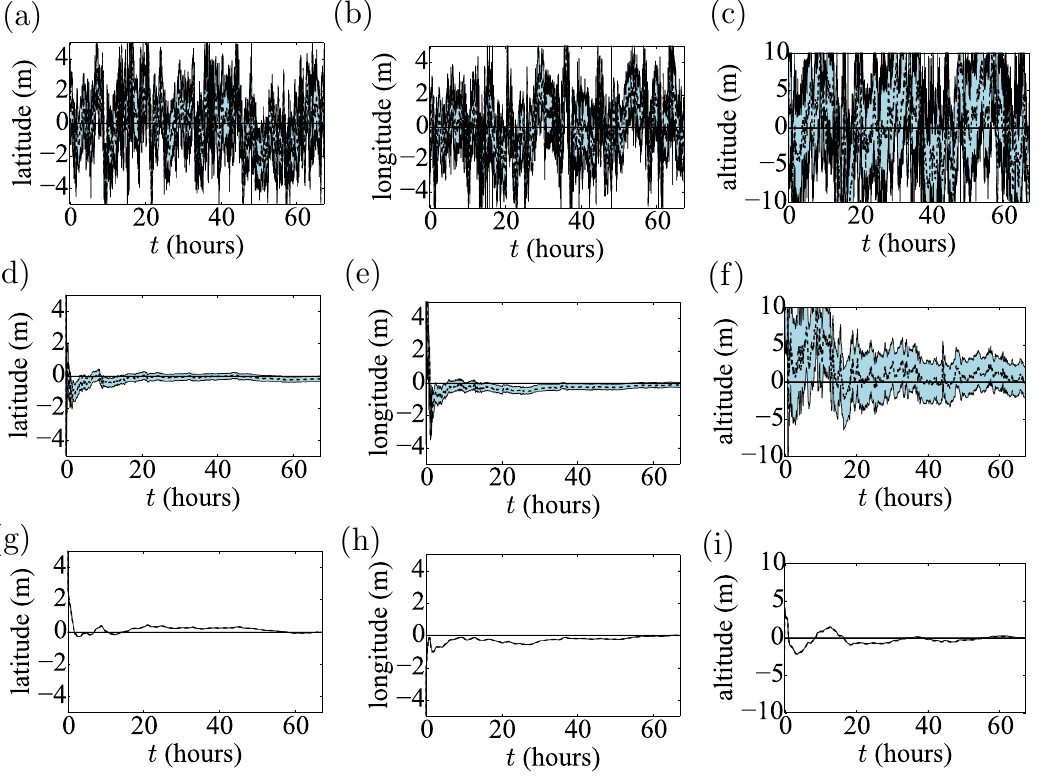
Figure 5. ( a – c ) The residuals are plotted for latitude ( a ), longitude ( b ) and ( c ) altitude as measured by a stationary receiver at Port Douglas. ( d – f ) The time-series of the inferred coordinates by an unscented Kalman filter algorithm equipped with OU noise model. The dataset plotted in ( a – c ) is used by this algorithm. Shaded regions represent the 90% credible intervals. ( g – i ) The same as the middle row, but using a Brownian model with process noise Σ d = 1m 2 within the